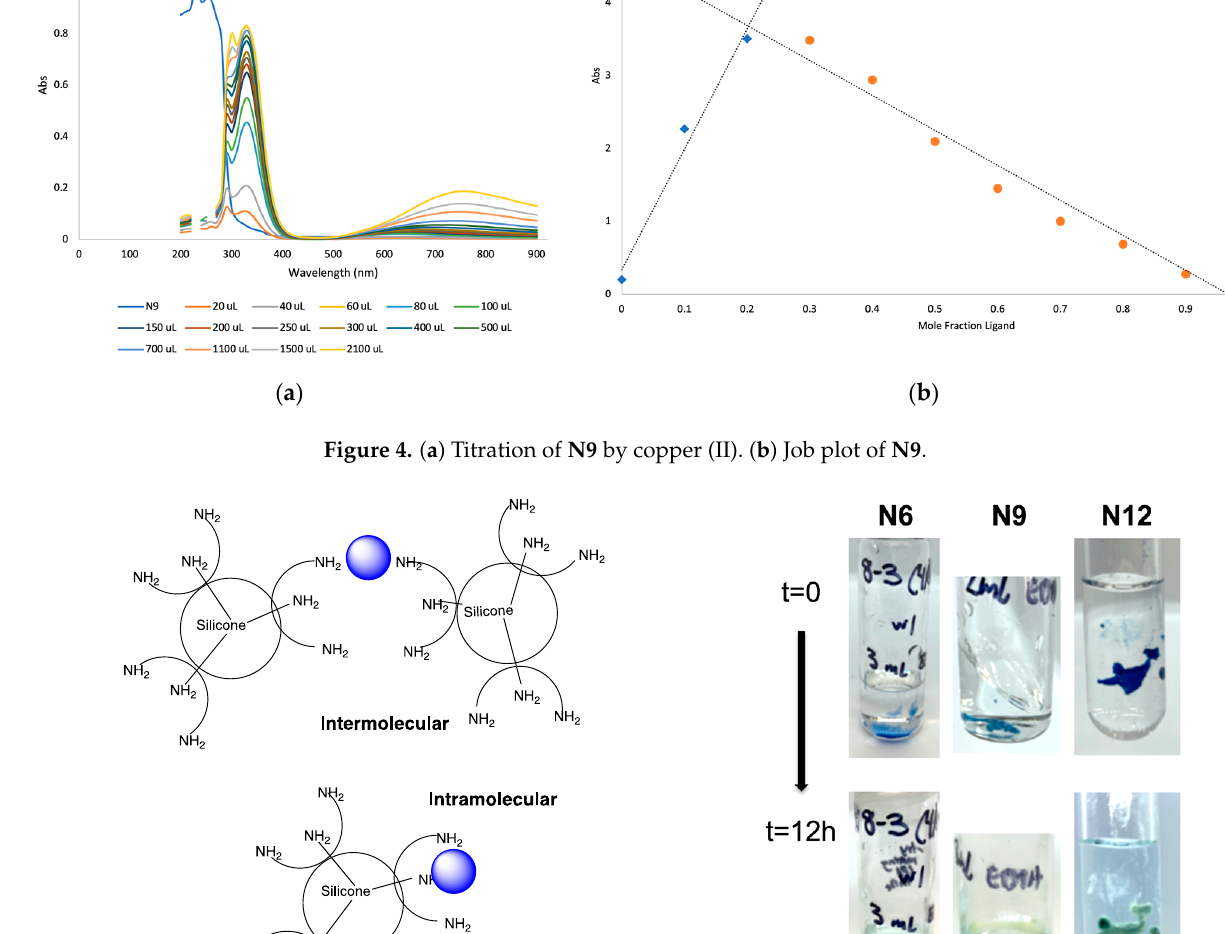
Figure 5. ( a ) Inter- vs. intramolecular chelation for N9 , the former leading to crosslinks. ( b ) Transfer of ions from chelated silicones to aqueous EDTA solution over 12 h.